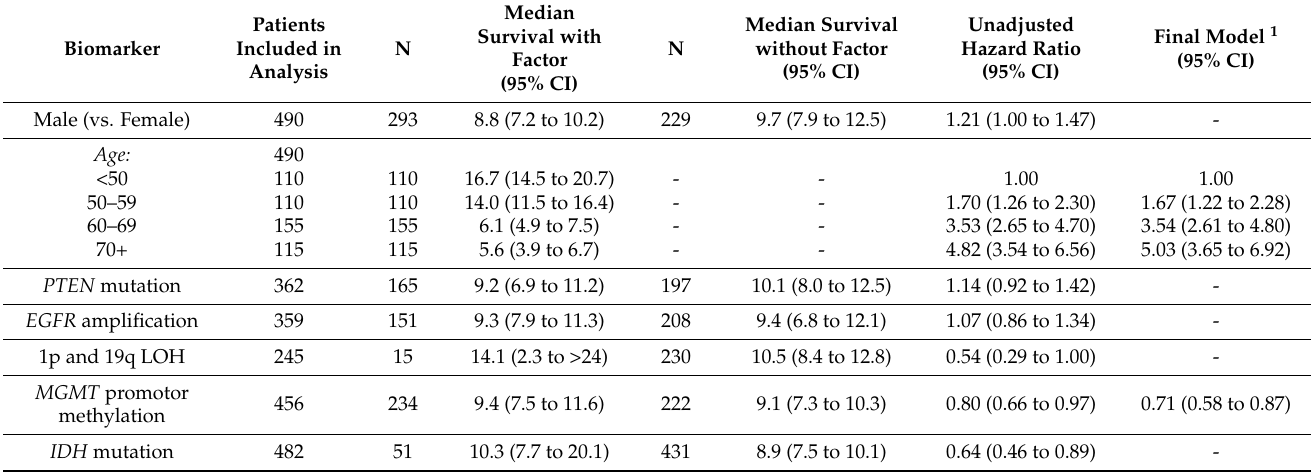
Table 2. Univariate and multivariate analyses of treatment independent survival